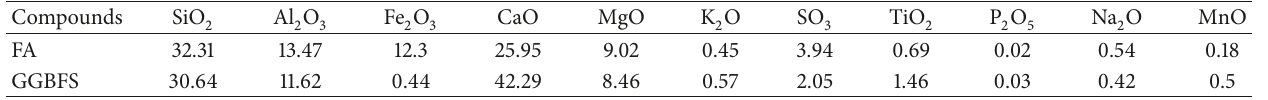
Table 1: Chemical composition of FA and GGBFS